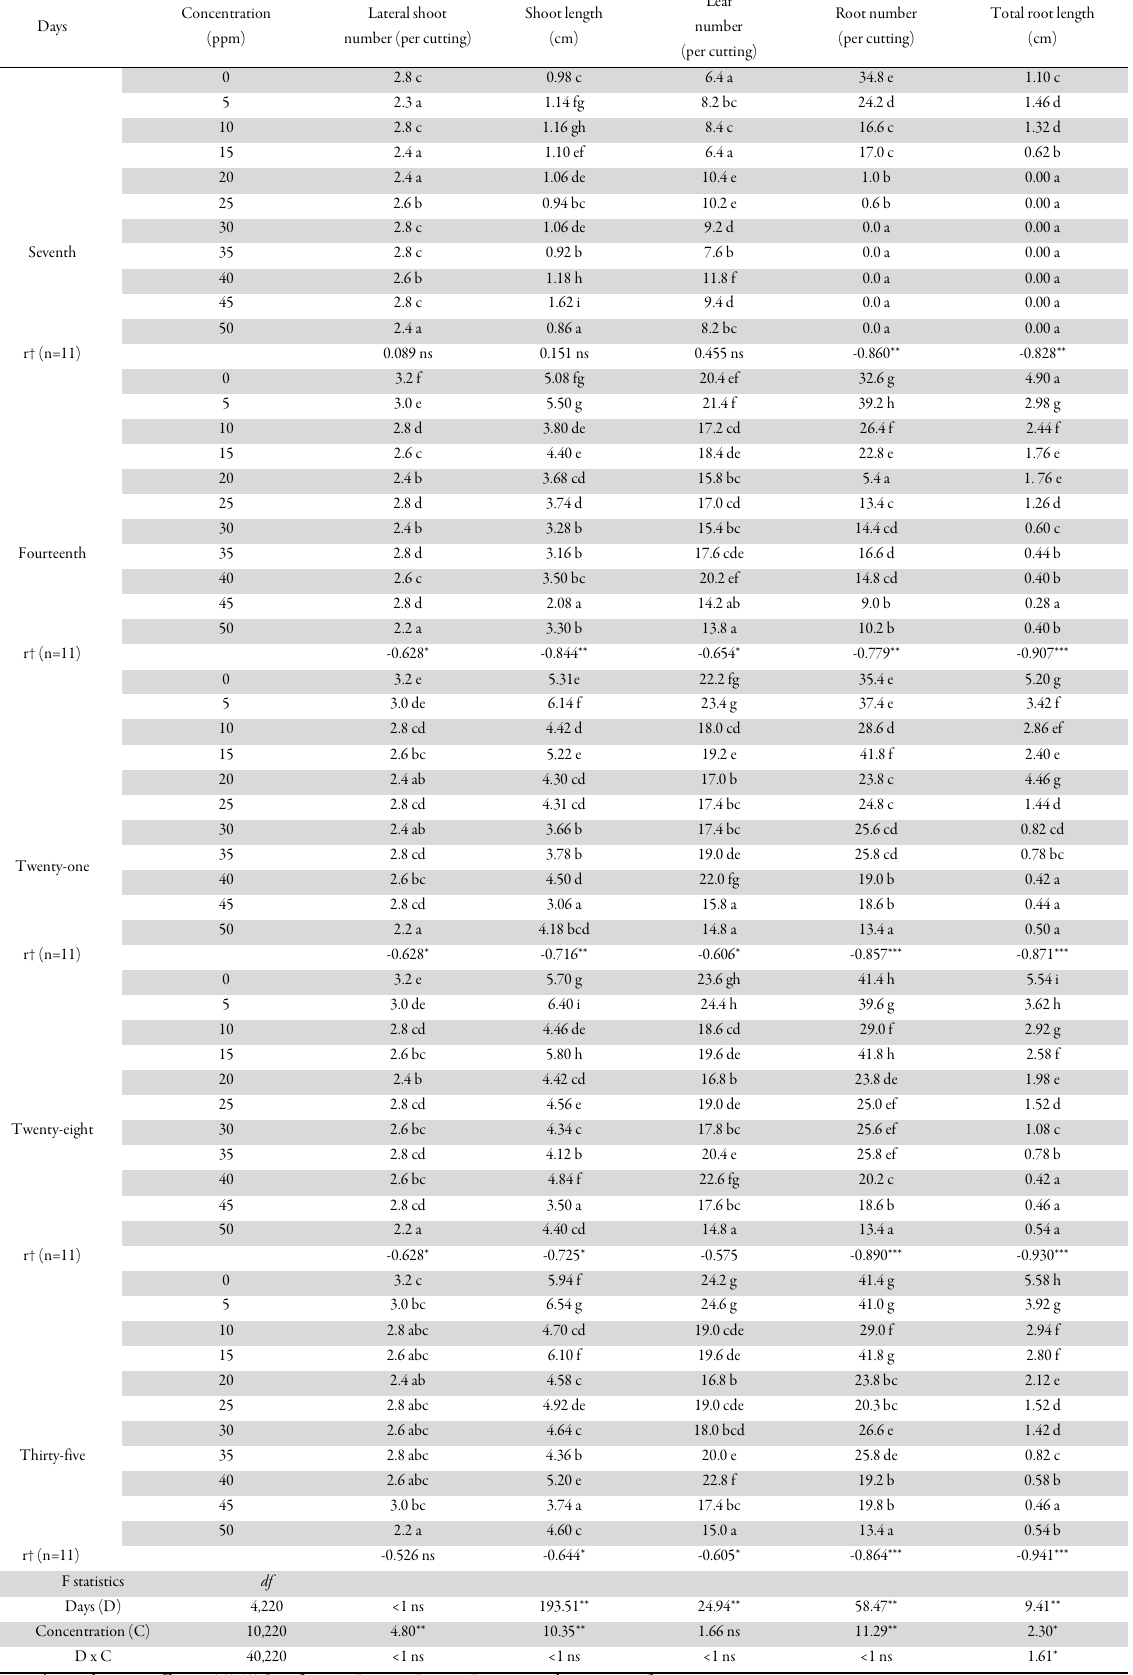
534 Table 2. Influence of different concentrations of Zn on the regeneration of Talinum portulacifolium stem cuttings over a period of 35 days